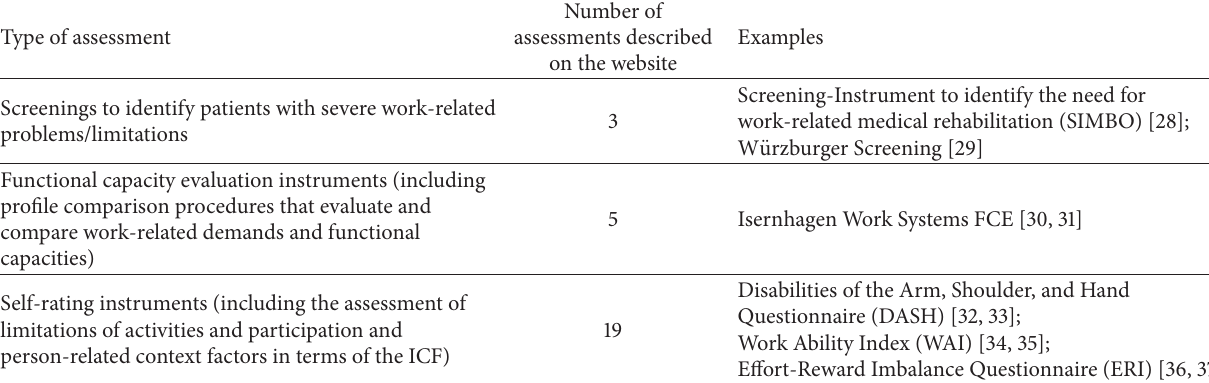
Table 2: Assessments/diagnostic tools illustrated on the website with examples.